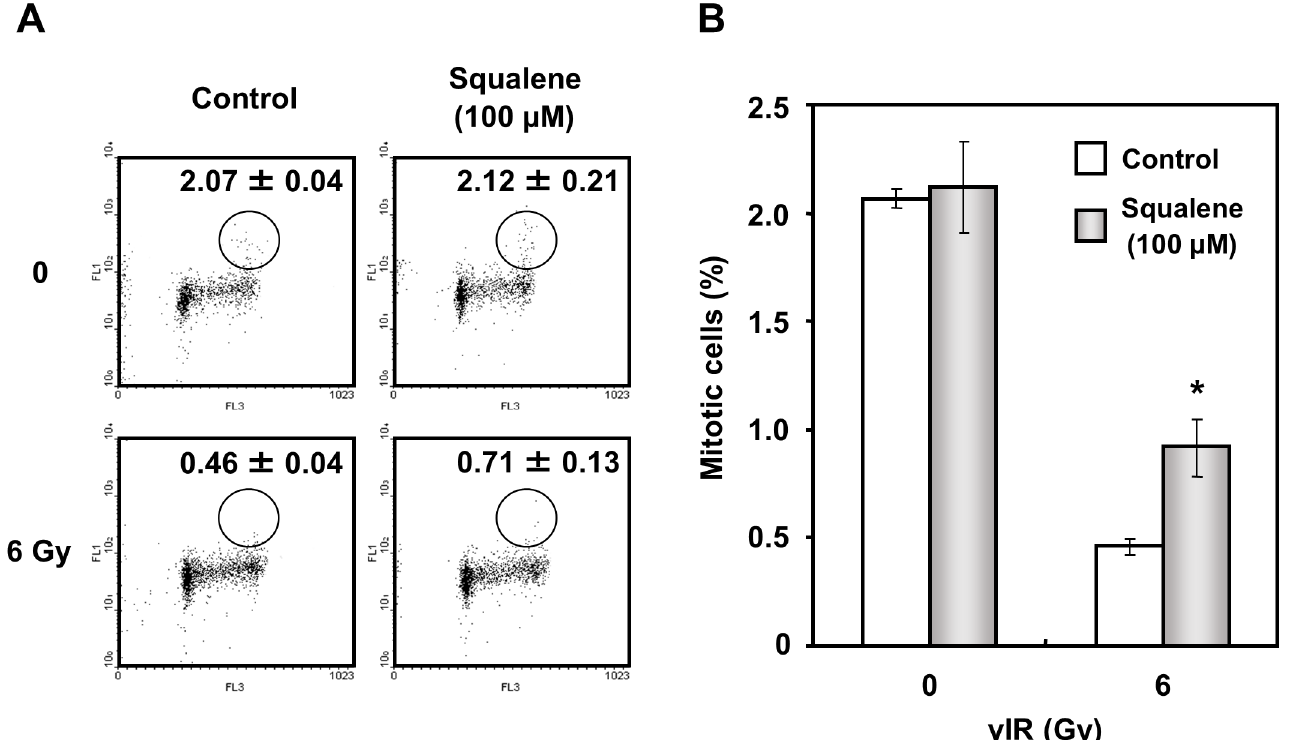
Fig 4. Effect of squalene on G2/M checkpoint activity. G2/M checkpoint analysis was performed by flow cytometry. (A) The percentage of mitotic cells was estimated according to the phosphorylation of histone H3 in Ser10-positive cells. A549 adenocarcinoma cells were counterstained with PI for visualization of DNA content. The cells were treated with 100 μ M squalene for 4 h before and 1 h after γ IR (0 and 6 Gy). (B) Data are expressed as the percentage of mitotic cells in the total number of cells. Data are presented as the mean ± S.D. of three independent experiments ( * P < 0.05 vs. untreated